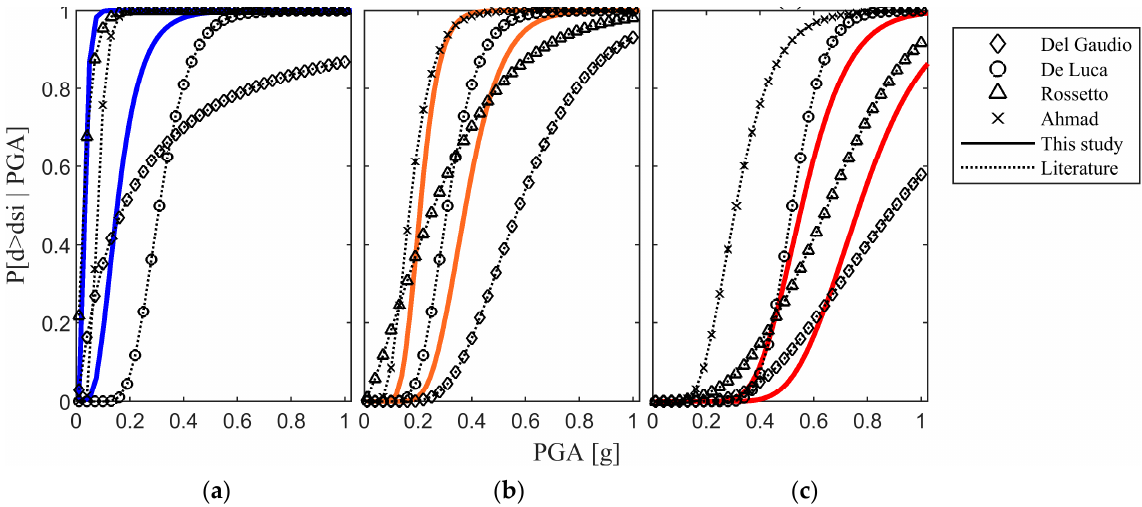
Figure 10. Fragility curves: observational ( a ) Del Gaudio et al. [30]; ( b ) De Luca et al. [31]; ( c ) Rossetto and Elnashai [5]; and analytical ( d ) Ahmad et al. [22].